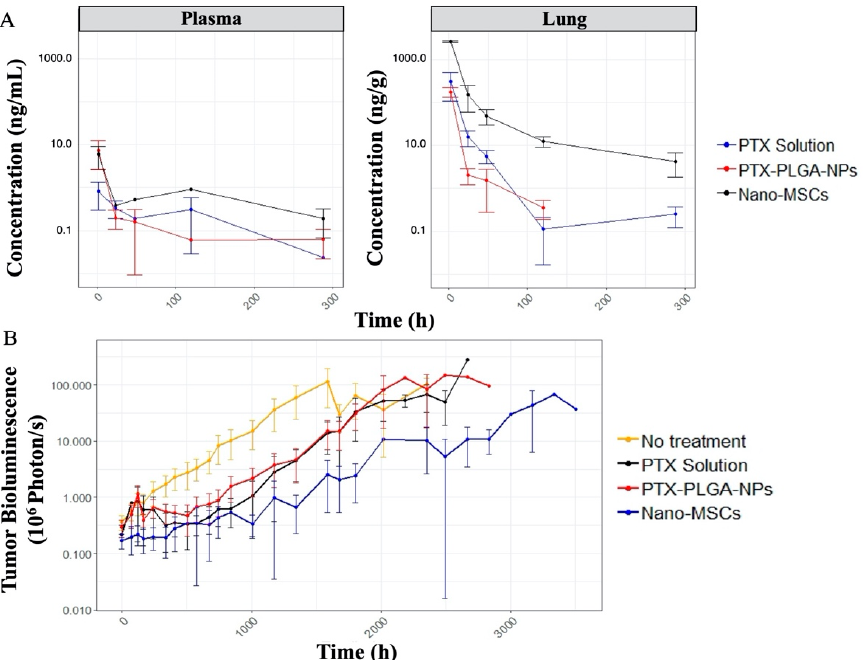
Figure 3. PK (A) and PD (B) data exploratory plots. The plots are on log scales. The dots and error bars represent the mean and 95% confidence intervals of either PTX concentration ( A ) or tumor bioluminescence ( B ) at each time point of each treatment group. PK profiles ( A ) is further stratified by tissues (plasma: left ; lung: right ).